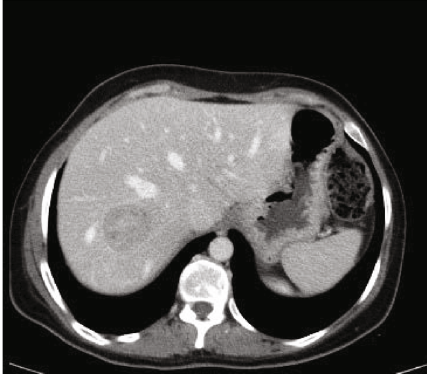
Figure 3: Axial CT view of the lesion, showing the lesion invading the liver parenchyma.